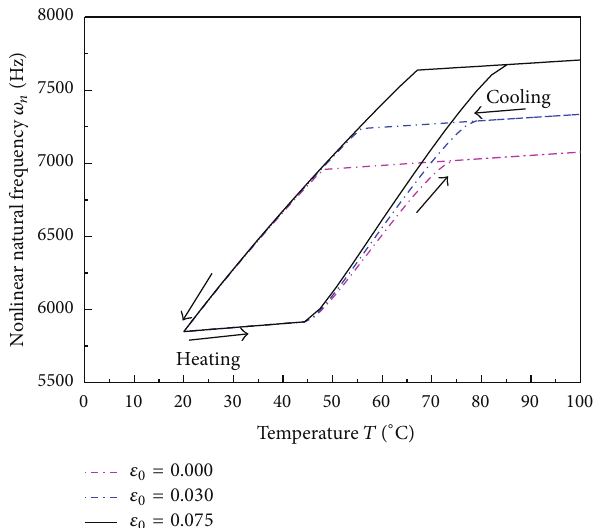
Figure 14: Amplitude 𝐴 versus frequency responses of the com- posite beams in the phase transformation state from martensite to austenite under the excitations ( T = 60 ∘ C, 𝜀 0 = 0.008 , 𝑞 0 = 10 N, and 𝐿/ℎ = 10